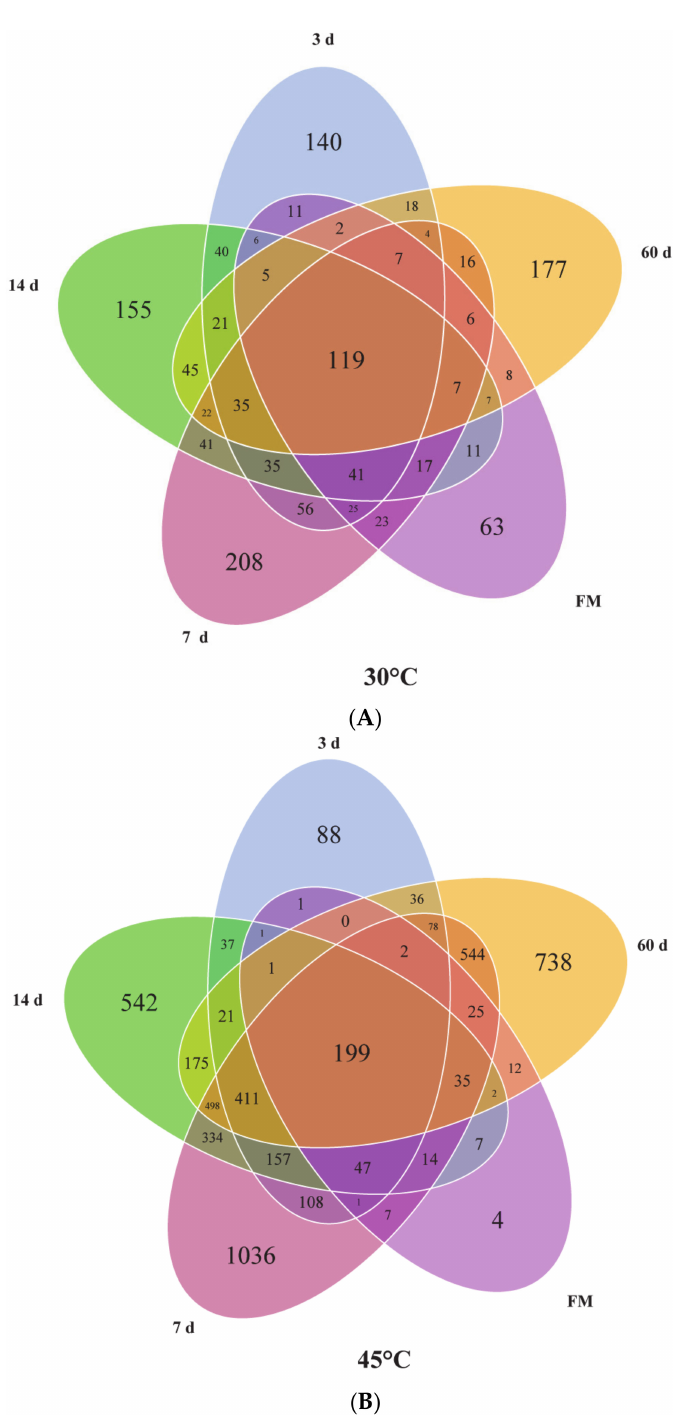
Figure 3. Venn diagram depicting unique or shared bacterial OTUs in silages for every period (FM: fresh material; 3 d; 7 d; 14 d; 60 d). ( A ) Venn diagram depicting unique or shared bacterial OTUs in silages for every period at 30 ◦ C; ( B ) Venn diagram depicting unique or shared bacterial OTUs in silages for every period at 45 ◦